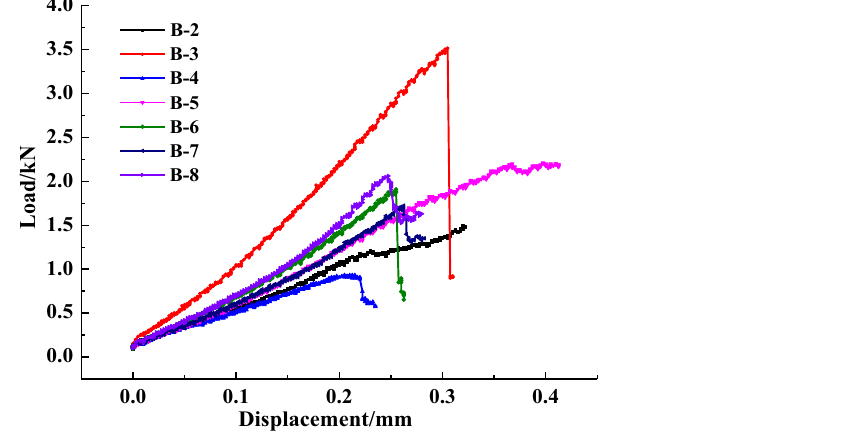
Figure 5. Load–displacement curves for the